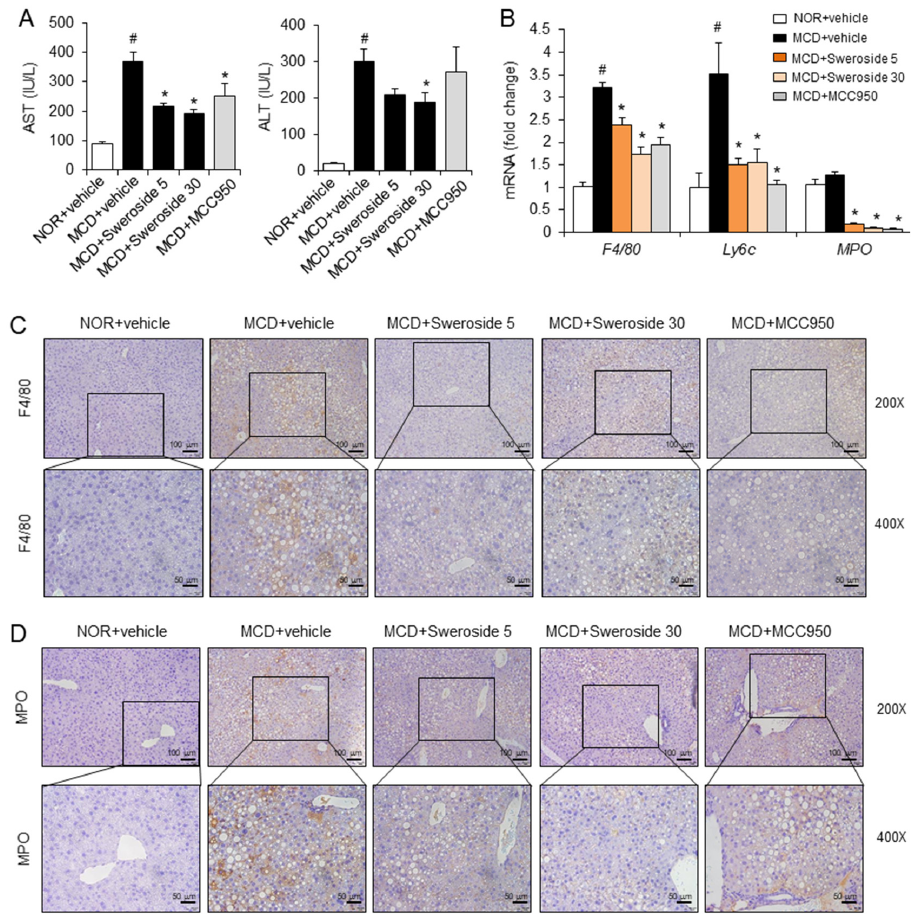
Figure 3. Sweroside alleviates hepatic inflammation in mice fed an MCD diet. C57BL/6 mice were fed a normal diet (NOR) or methionine-choline-deficient diet (MCD) for two weeks. Sweroside (5, 30 mg/kg) or MCC950 (20 mg/kg) was administered with daily intraperitoneal injections with the diets. ( A ) Serum AST and ALT levels were determined. ( B ) Hepatic mRNA levels for total macrophages ( F4/80 ), inflammatory macrophages ( Ly6c ), and neutrophils ( MPO ). ( C , D ) Representative immunohistochemistry liver sections stained for F4/80 and MPO (200X and 400X). For A and B, the values represent means ± SEM ( n = 8). #, significantly different from NOR + vehicle, p < 0.05. *, significantly different from MCD + vehicle, p < 0.05.